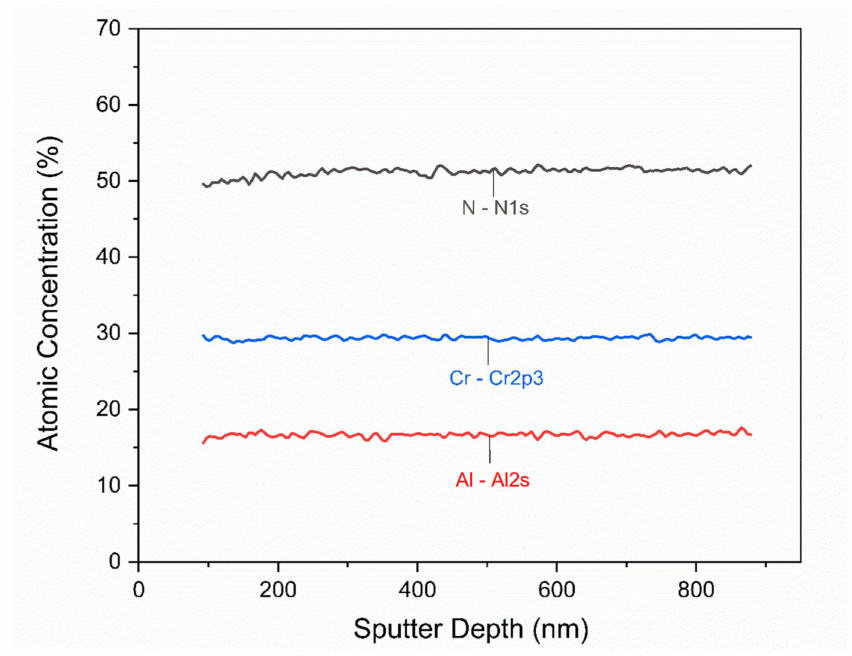
Figure 5. The XPS depth profile of the chemical composition across the CrN/CrAlN multilayer deposited onto a gas-nitrided diesel piston ring using the M02